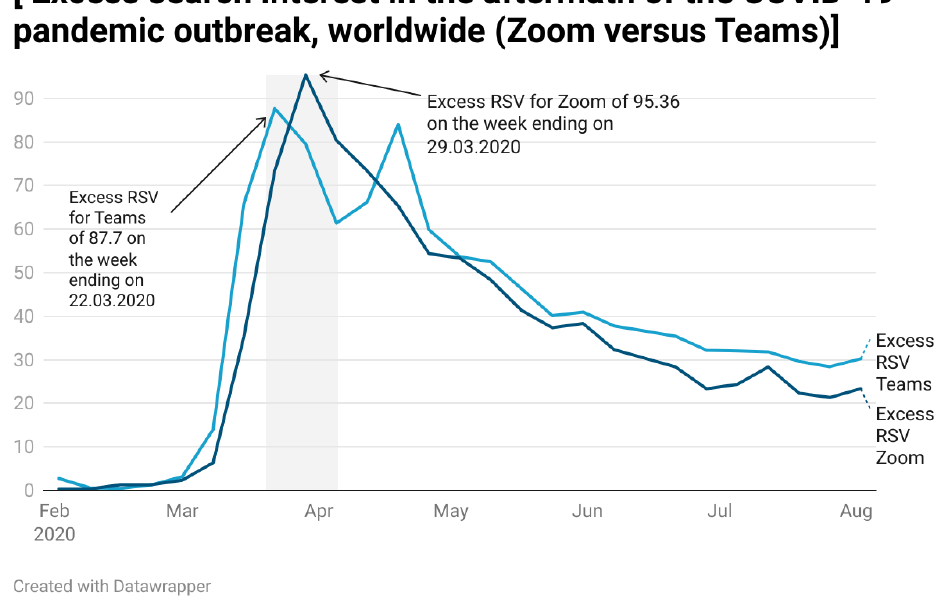
Figure 5. Excess search interest for the two main SaaS programs Zoom and Teams during February–August 2020. Source of data: estimation results. Chart created in Datawrapper.